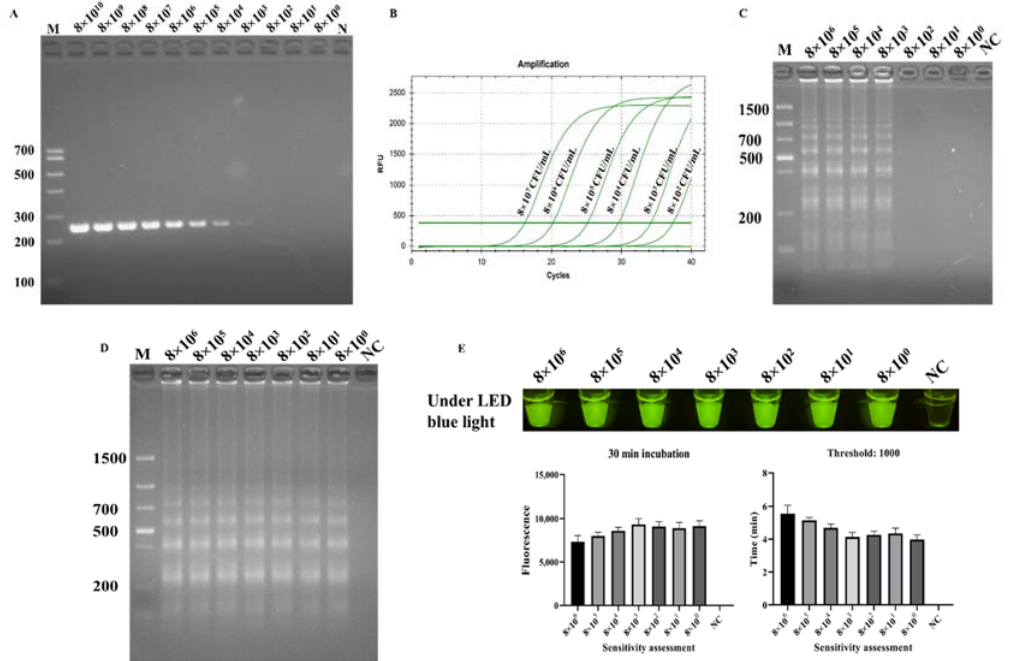
Figure 6. Sensitivity evaluation ICB-LAMP-CRISPR/Cas12a. The sensitivity of ICB-LAMP-CRISPR/Cas12a was compared with- that of PCR, qPCR, LAMP, and ICB-LAMP. Serial tenfold dilutions of C. jejuni (8 × 10 0 –8 × 10 10 CFU/mL) were used for the sensitivity evaluation. The sensitivity evaluation results of PCR, LAMP, and ICB-LAMP were shown by agarose gel electrophoresis. The sensitivity evaluation results of qPCR and ICB-LAMP-CRISPR/Cas12a are shown by the real-time amplification curve and end-point fluorescence. ( A ) The sensitivity evaluation of PCR. ( B ) The sen- sitivity evaluation of qPCR. ( C ) The sensitivity evaluation of LAMP. ( D ) The sensitivity evaluation of ICB-LAMP. ( E ) The sensitivity evaluation of ICB-LAMP-CRISPR/Cas12a.